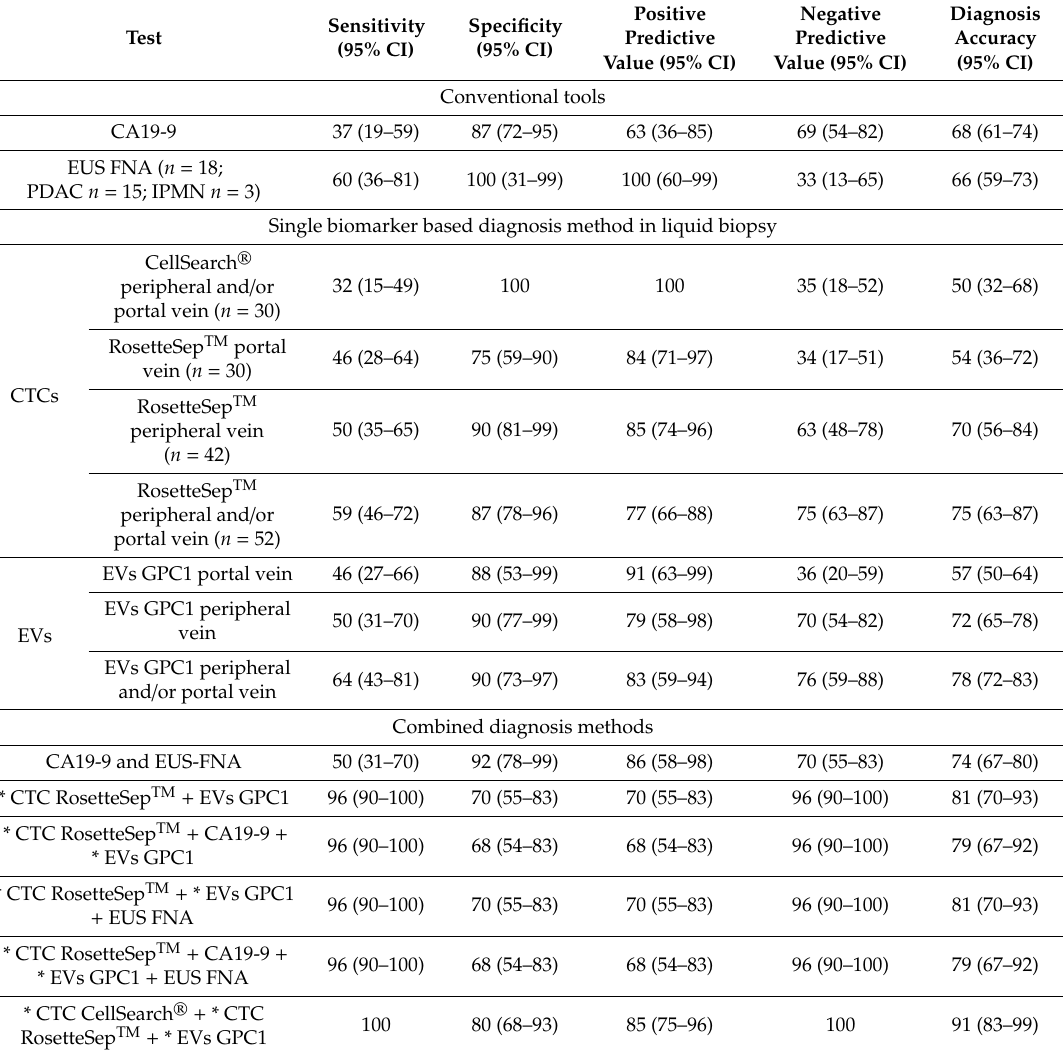
Table 2. Diagnosis values of GPC1-positive exosomes, CTC detection by CellSearch ® , and CTC quantification by RosetteSep TM , CA 19-9, and